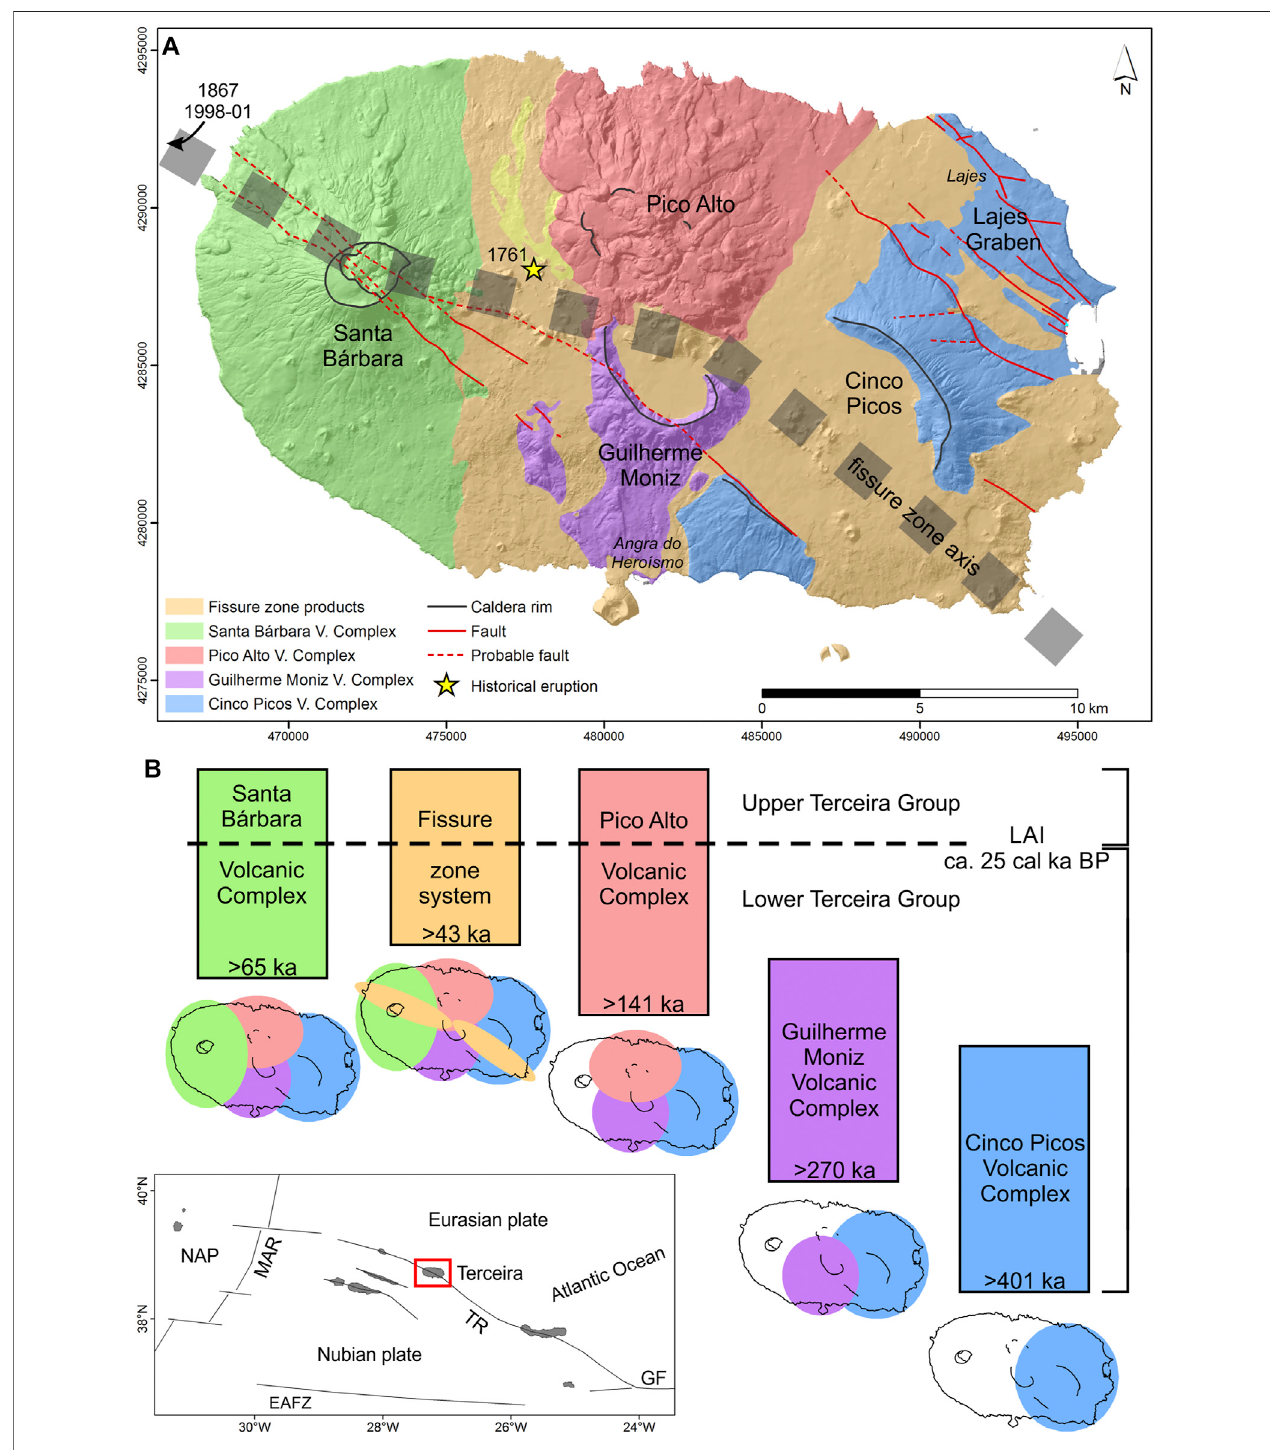
FIGURE 1 | (A) Simpli fi ed geological map of Terceira Island (modi fi ed from Madeira, 2005); UTM coordinates, zone 26S. (B) Stratigraphic scheme and reconstruction of the different phases of evolution of Terceira Island (ages from Calvert et al., 2006; Gertisser et al., 2010; Hildenbrand et al., 2014); LAI — Lajes-Angra IgnimbriteFormation.InsetshowsthegeodynamicsettingoftheAzoresarchipelagoandmainstructuralfeaturesoftheregion(NAP — NorthAmericanplate;MAR — Mid- Atlantic Ridge; TR — Terceira Rift; EAFZ — East Azores Fracture Zone; GF — Gloria Fault).